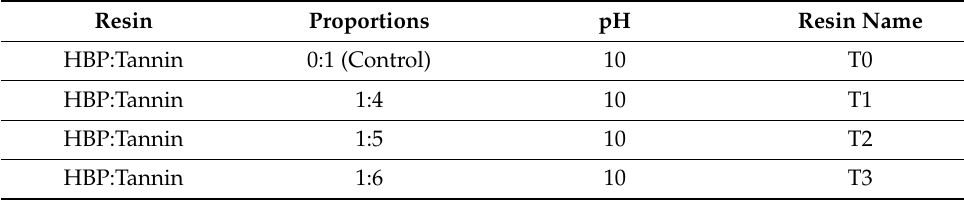
Table 1. Weight proportions of HBP:tannin solids in the resin tested. Resin Proportions pH Resin